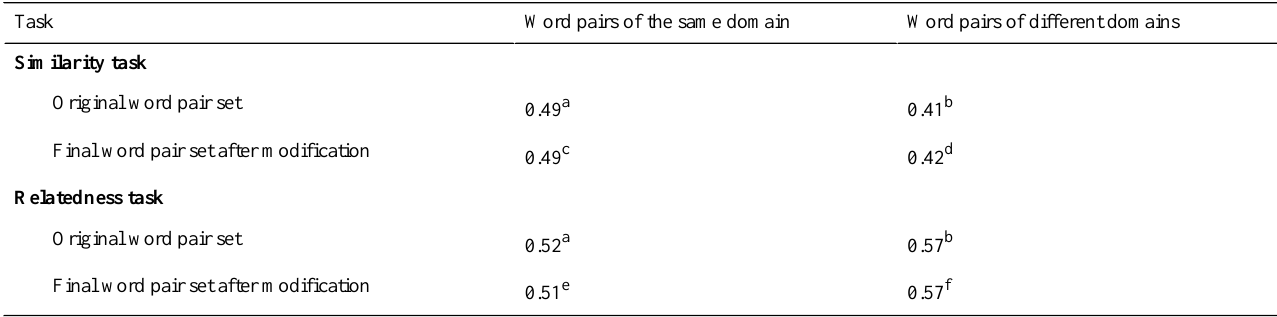
Word pairs of different domainsWord pairs of the same domainTask